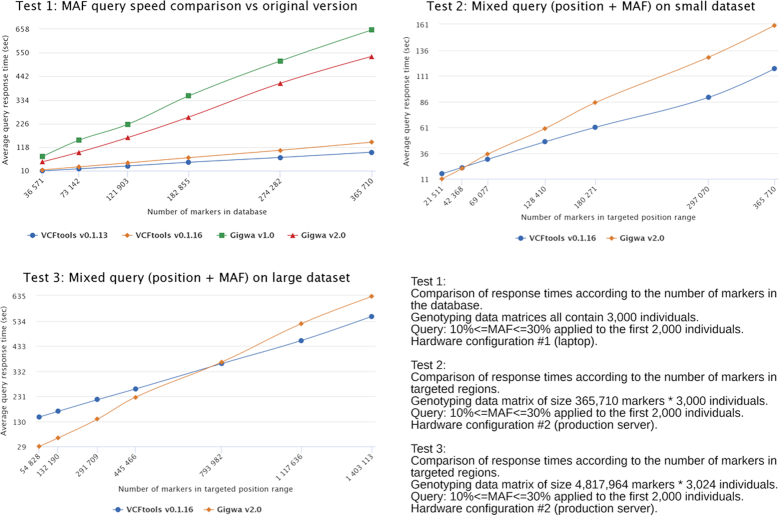
Benchmark results.